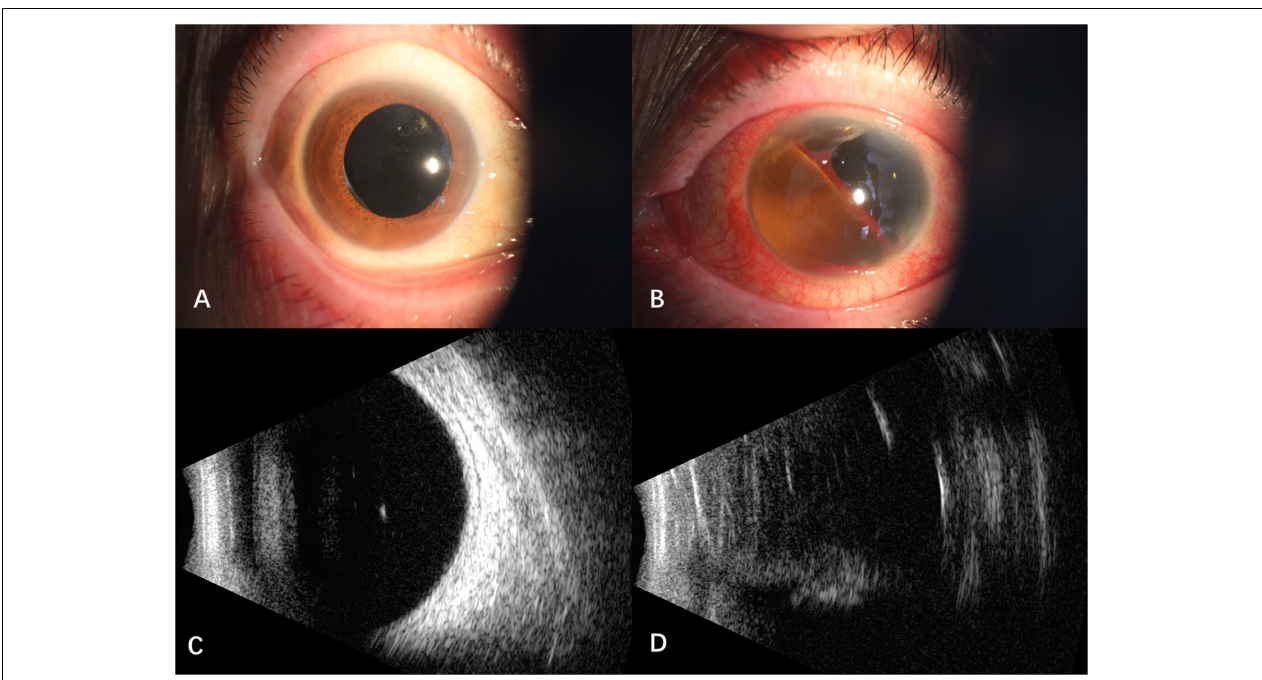
FIGURE 2 | Anterior segment and B -scan ultrasonography of the patient 5 weeks after the onset of intraocular hemorrhage. (A) Hemorrhage in the anterior chamber of the right eye absorbed; (B) intraocular lens was removed and the hemorrhage absorbed in the left eye; (C) no vitreous hemorrhage in the right eye; (D) vitreous silicone oil filling with retinal detachment in the left